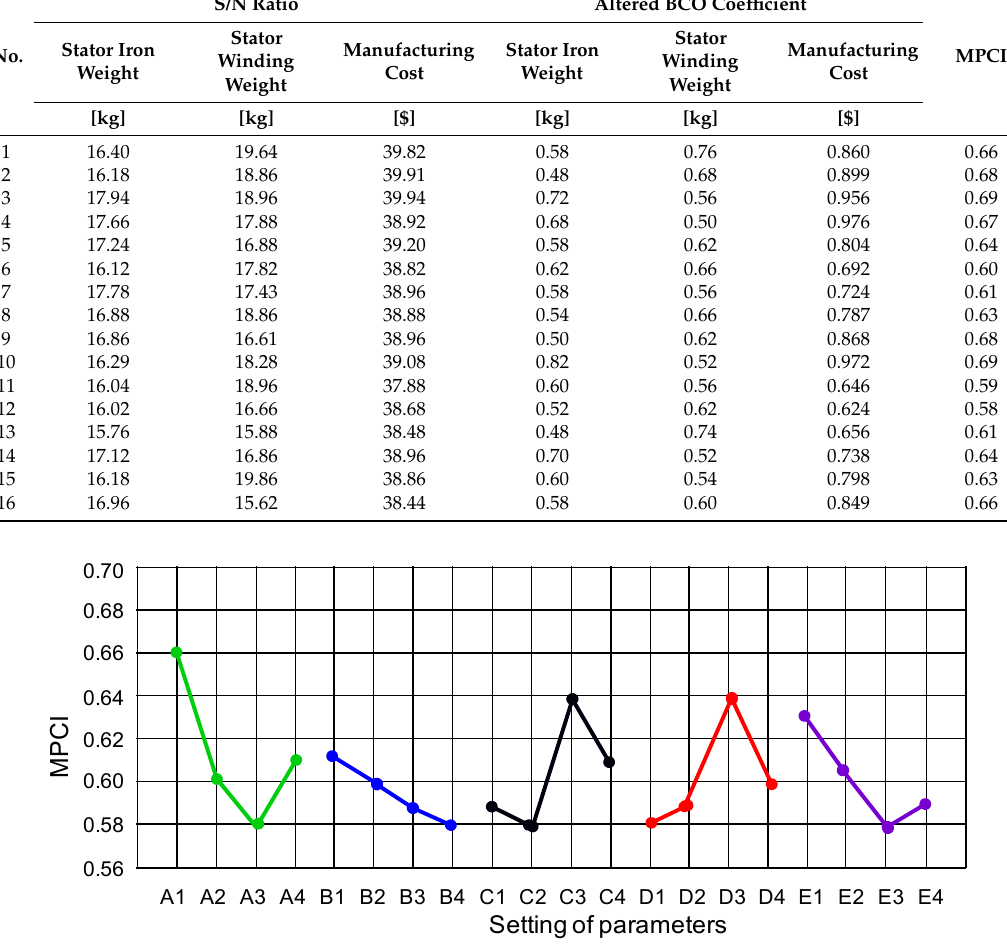
Table 5. Transformations matrix of S/N ratios, altered BCO coefficient and MPCI.